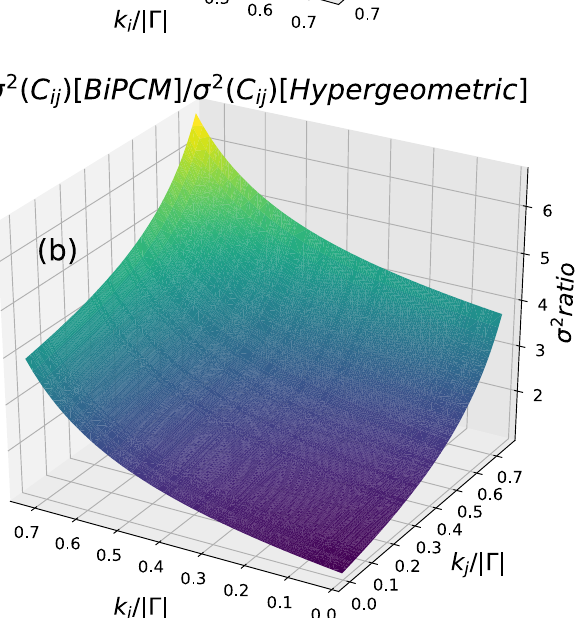
Fig. 4 Density ρ of links validated by the various null models as a function of the signi fi cance threshold p * . The dashed bisector denotes the noise level, namely the probability to statistically validate a link generated by the null model. The four null models leads to different results even for the same p * value.